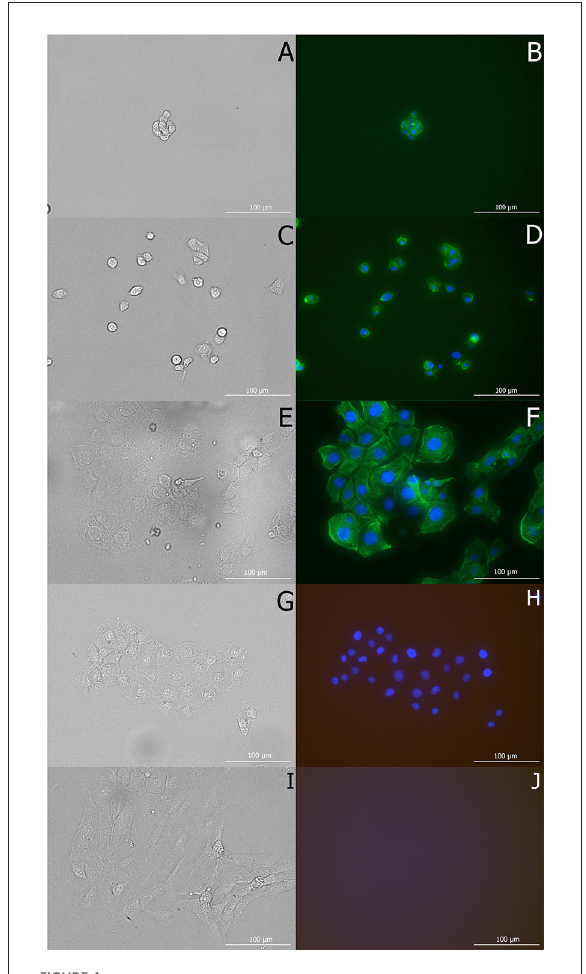
FIGURE4 Morphology of macrophage cells in vitro in Experiment 1 after 48h of incubation at test temperatures (8, 17.5, and 37 ◦ C). Cells are visualized with a Cytation 1 microscope in brightfield ( A,C,E , respectively) and fluorescent channels (GFP, DAPI) using counterstaining of actin filaments (green) and nuclear structures/DNA (blue). Control cells, treated with DAPI for calibration, captured in bright field (G) and all fluorescent (Texas red, GFP, DAPI) channels (H) and untreated cells under the same conditions (I,J) .